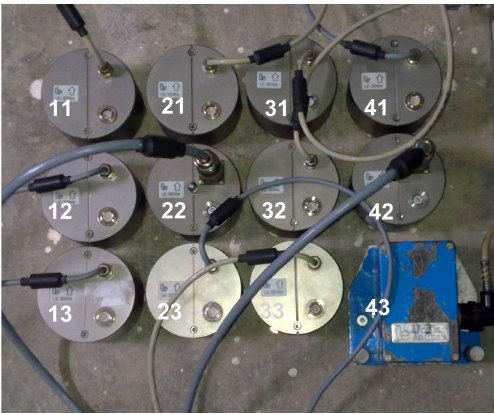
Figure 7. The Lennartz LE-3DLite huddle test lay-out. The centers of the sensors are arranged in a rectangle of 22.5 cm × 31.5 cm.